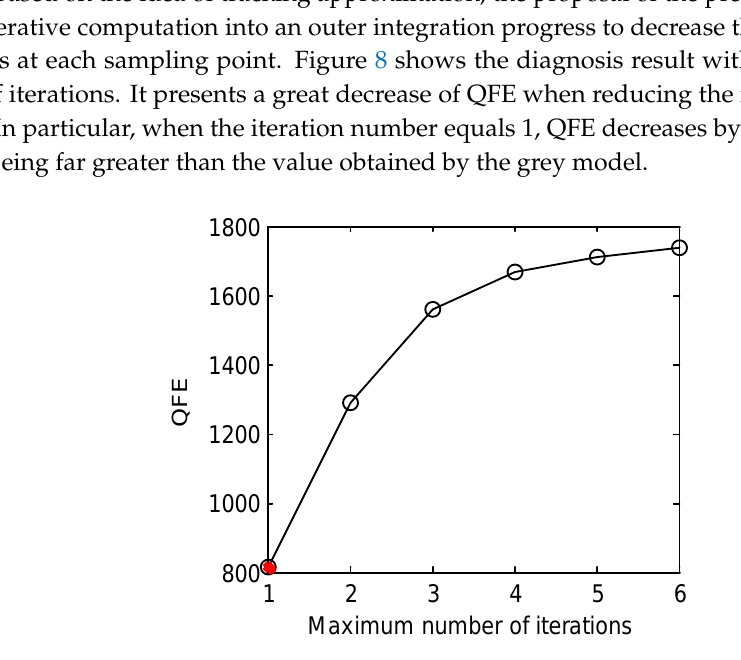
ff erent numbers of Figure 8. Fault diagnosis of fault 7 with different numbers of iterations. Figure 8. Fault diagnosis of fault 7 with di Figure 8. Fault diagnosis of fault 7 with different numbers of iterations.